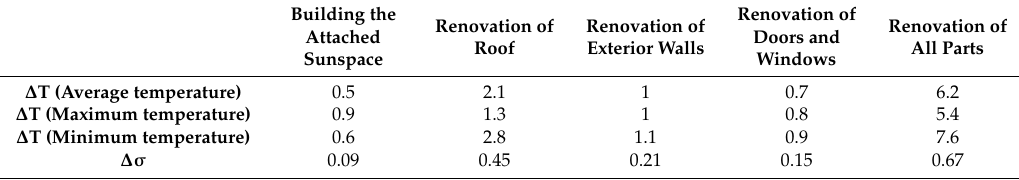
Table 10. E ff ects of di ff erent renovation measures on indoor temperature.